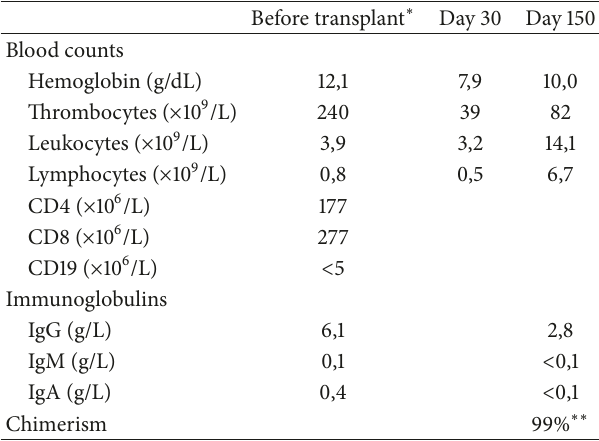
Table 1: Hematologic and immunologic